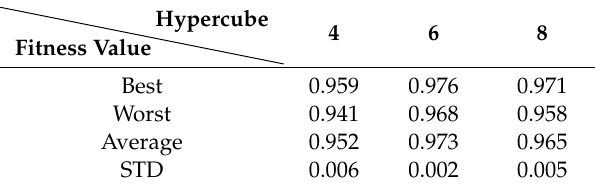
Table 2. Benefits of di ff erent